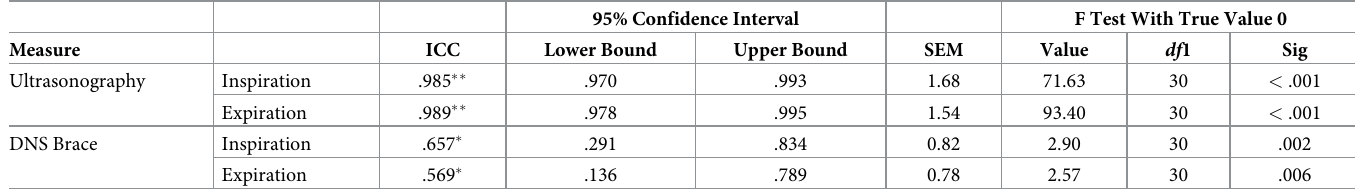
Table 2. Intraclass correlation coefficients of ultrasonography and DNS brace values during tidal inspiration and expiration (ICC 2, k